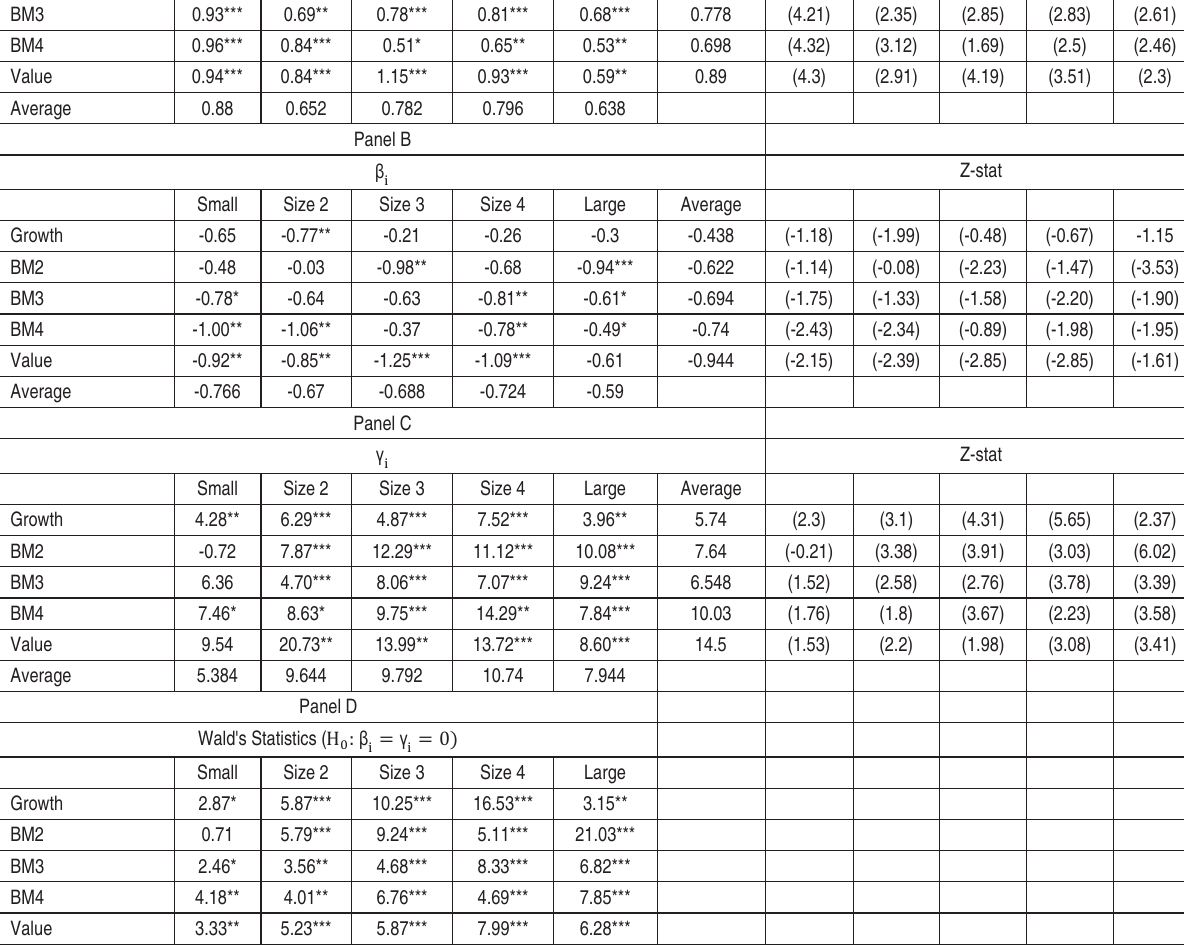
Table 7. (cont.). The Impact of monetary policy shocks on the ERP of the 25 value-weighted Fama-French